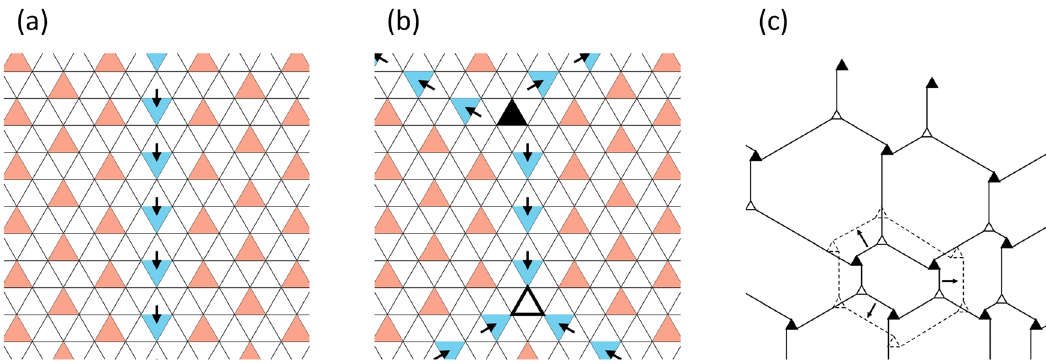
Fig. 2 Visual representation of the "breathing entropy" argument for no-touching trimer tilings. a Starting from a uniform and sublattice-polarized ffiffiffi p ffiffiffi p ´ 3 3 state (red triangles), a line of trimers can be " fl ipped" (from red to blue triangles), which spans the length of the sample. Any such line of fl ips must span the sample, and there are three directions a line can extend in. b Three lines of fl ips can either meet in an inverted "Y" joint (bottom), resulting in ffiffiffi p ffiffiffi p ´ a vacancy of the original 3 3 con fi guration (open black triangle), or in an upright "Y" joint (top), resulting in the addition of a new Wannier state ( fi lled black triangle). c Together, the three line directions and two types of junctions form a network of irregular hexagons. As the locations of the joints are not fi xed, the hexagons can be freely deformed (black arrows), leading to the extensive "breathing entropy" of